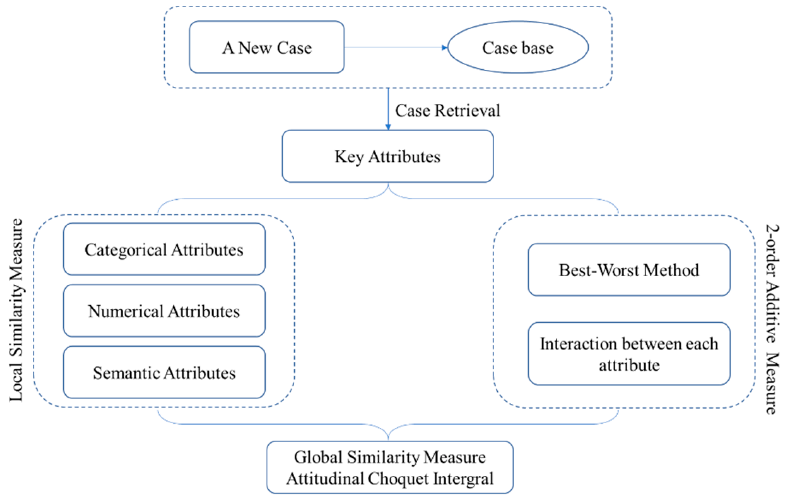
Figure 1. Framework of the proposed case-based reasoning (CBR) system.